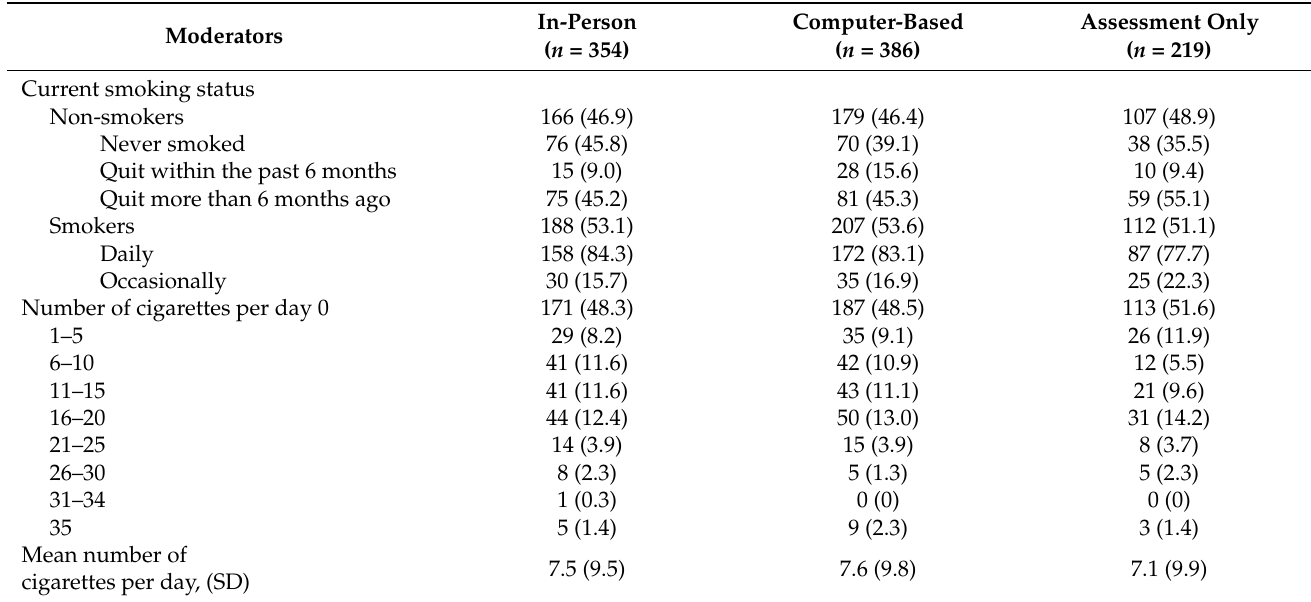
Table 1. Moderator characteristics at baseline stratified by study group, n (%).